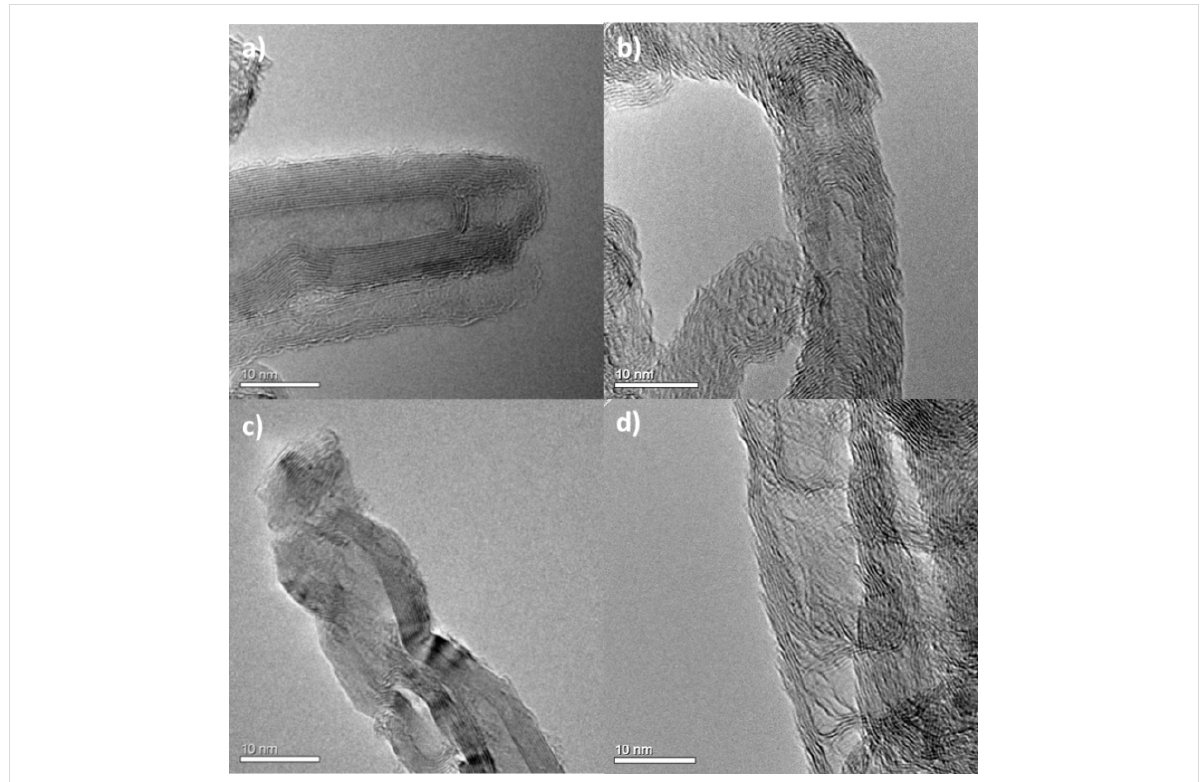
Figure 1: HRTEM micrographs of: a) CNTs; b) N-CNTs; c) S-CNTs, and d) N-CNTs HT . (Scale bar = 10